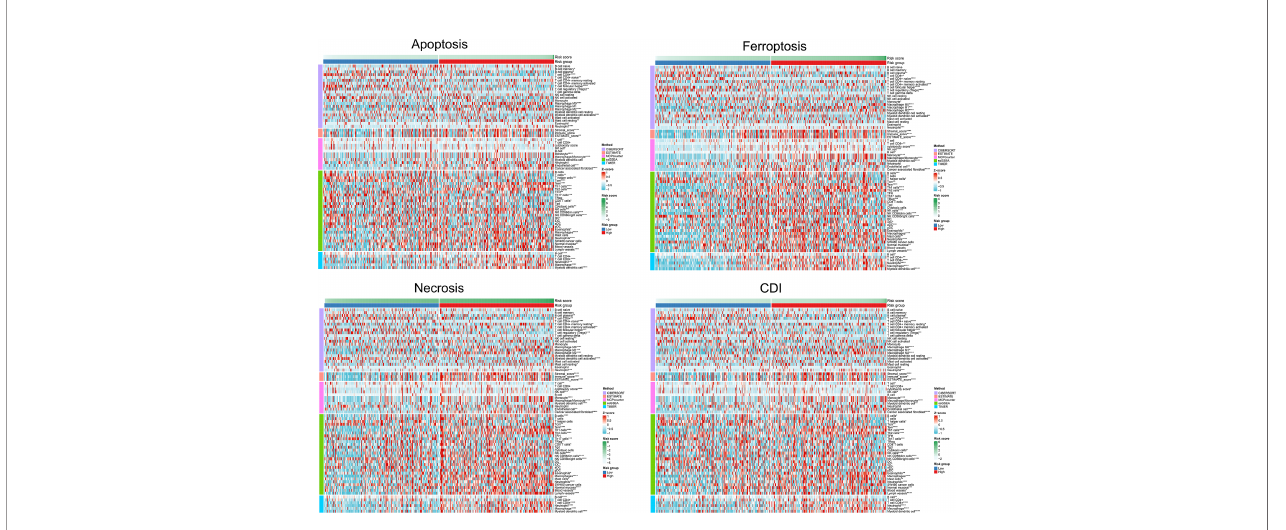
FIGURE 7 | Differential TME parameters associated with cell-death pathways. The clustering heat map showed lymphocytes and other TME parameters for each cell-death risk group. * P < 0.05; ** P < 0.01; *** P < 0.001; **** P <